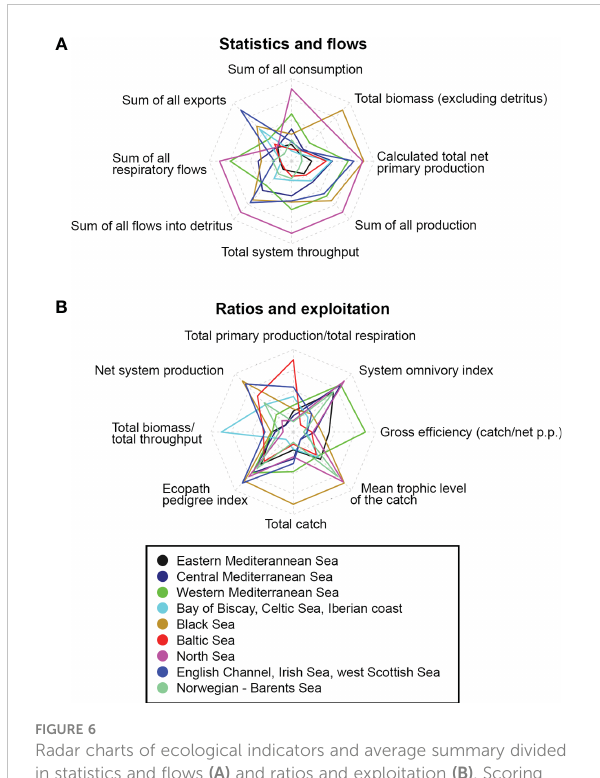
FIGURE 6 Radar charts of ecological indicators and average summary divided in statistics and fl ows (A) and ratios and exploitation (B) . Scoring scale ranges from -2 to 2 for Ecopath models of the nine reviewed European marine areas. The units of the indicators are in accordance with Table